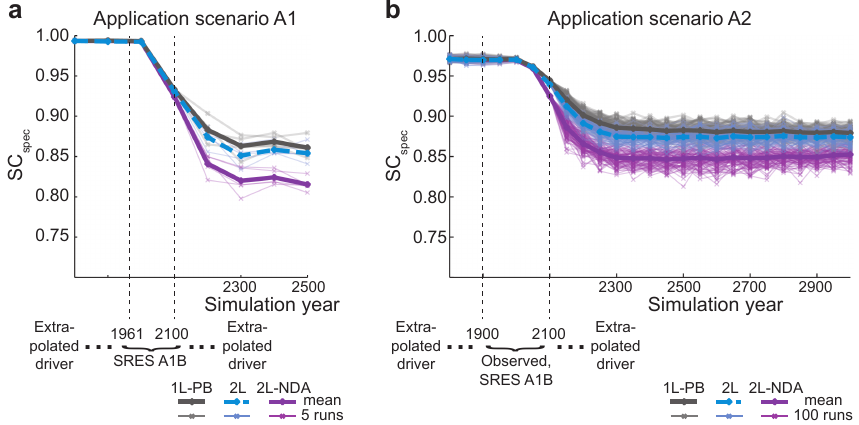
Figure 5. Temporal development of SC spec comparing the biomass per species. Depicted is the comparison of 1L-ORG simulations to two-layer simulations with and without dynamic associations (2L and 2L-NDA, respectively) and simulations on one layer but with the bioclimate of the associated bioclimate types (1L-PB). For both application scenarios (A1: a , A2: b ) bioclimate types were derived with the set of bioclimate bins with moderate resolution (E2; for other bioclimate types see Supplement Sect. S3). SC spec values for A1 were calculated every 100years and values for A2 every 50 years. For each setting several repetitions were compared, which were simulated using different pseudo-random number streams to extrapolate the bioclimate driver before 1961 (A1) or 1901 (A2) and after 2100. Five simulations were conducted for A1 and 100 for A2. Single simulations and their means are printed half-transparent and bold, respectively. All depicted SC spec time series decline in the transient phase of climate change and continue to decline for about 200years after which SC spec stabilises. Over the whole simulated time span SC spec values of 2L simulations are much closer to SC spec values from 1L-PB simulations than to SC spec values from 2L-NDA simulations, indicating that the deviations are mainly due to the averaging of the bioclimate